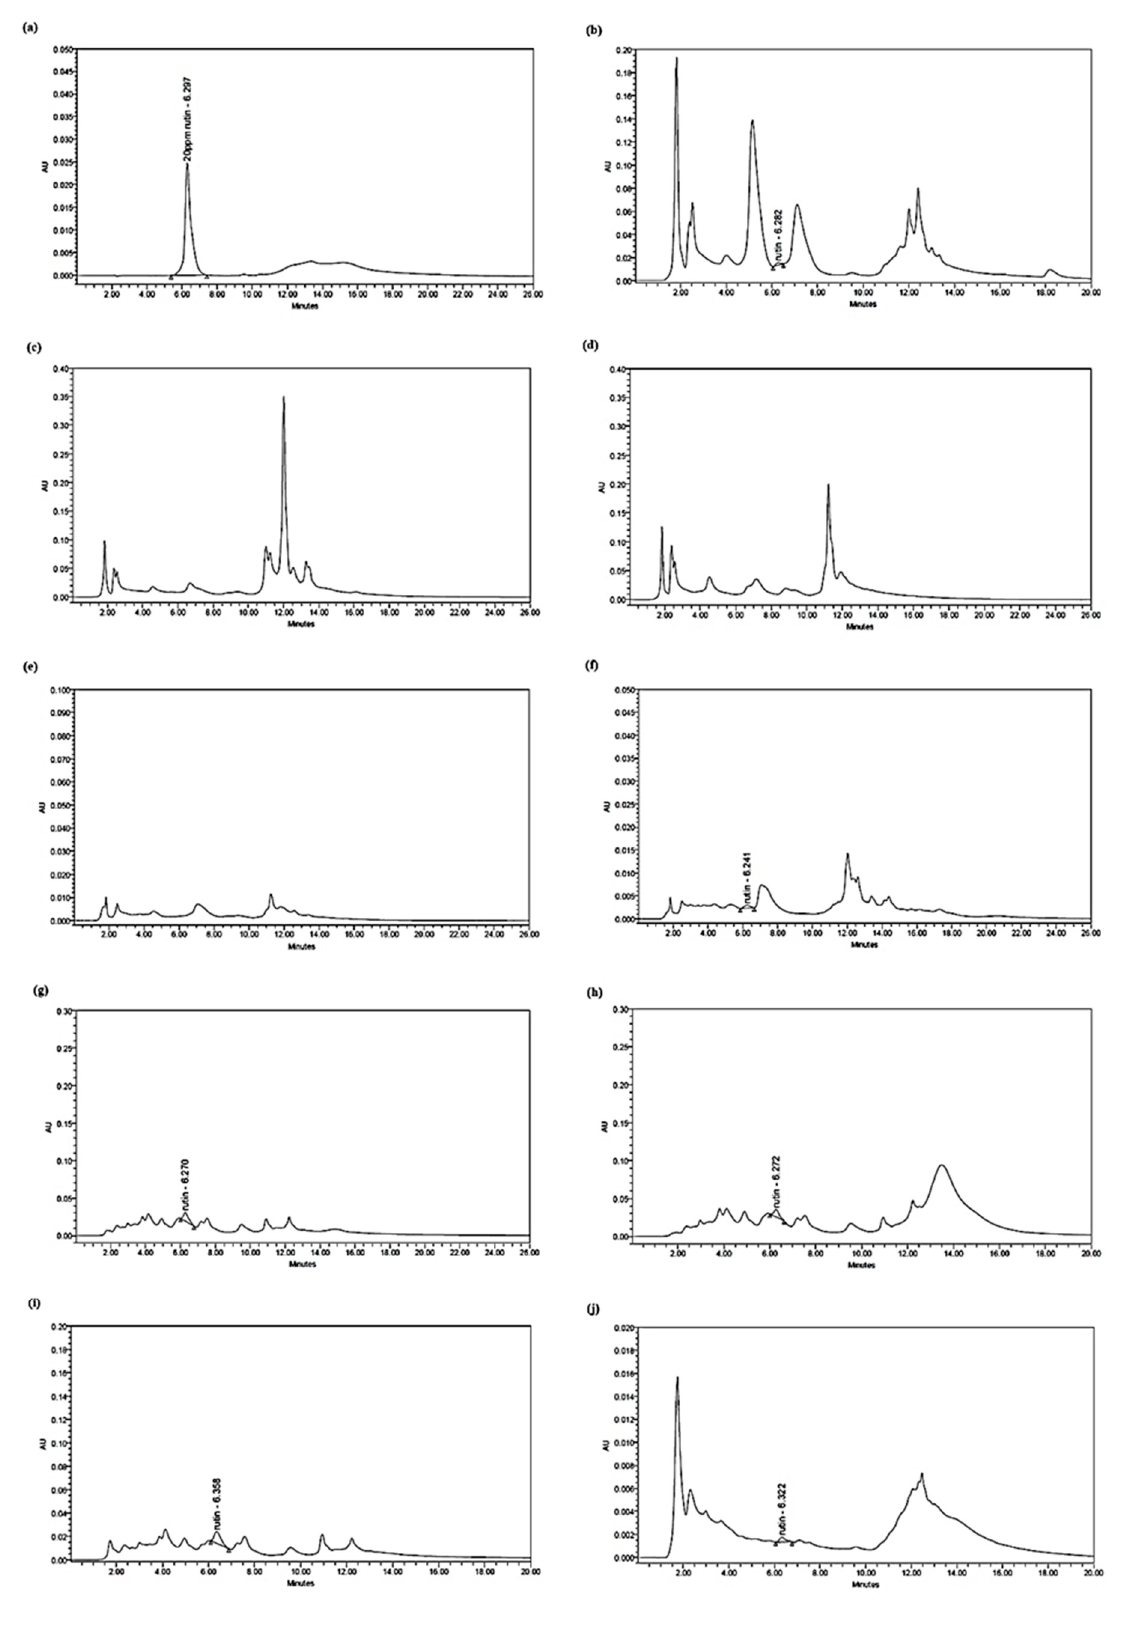
Figure 3. HPLC chromatograms of ( a ) rutin standard marker, ( b ) L. pumila var. pumila plant green leaf (LPPG), ( c ) L. pumila var. pumila plant red leaf (LPPR), ( d ) L. pumila var. alata plant (LPA), and L. pumila HMPs [( e ) KFP1, ( f ) KFP2, ( g ) KFP3, ( h ) KFP11, ( i ) KFP12, and ( j )